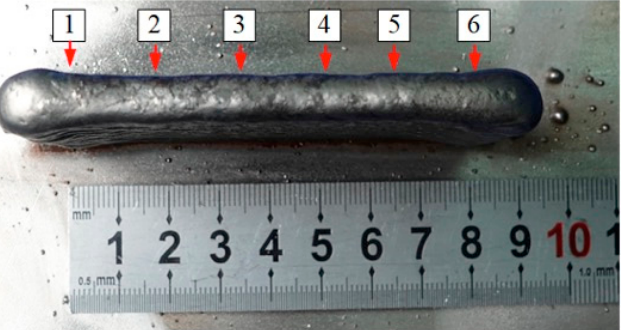
Figure 4. The schematic diagram of measuring position in the parts: numbers 1 to 6 represent the measuring position of the width and height.